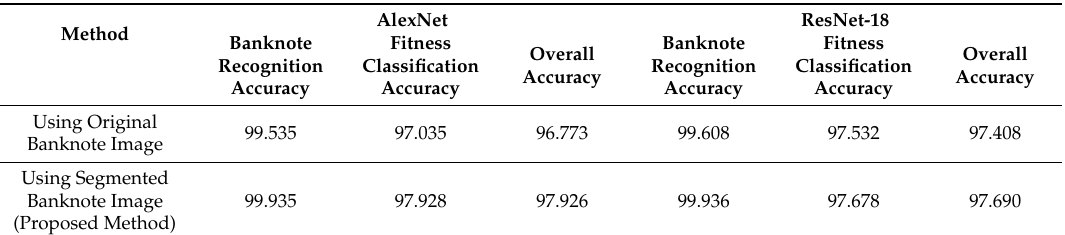
Table 8. Comparative experimental results of the proposed method between with and without banknote region